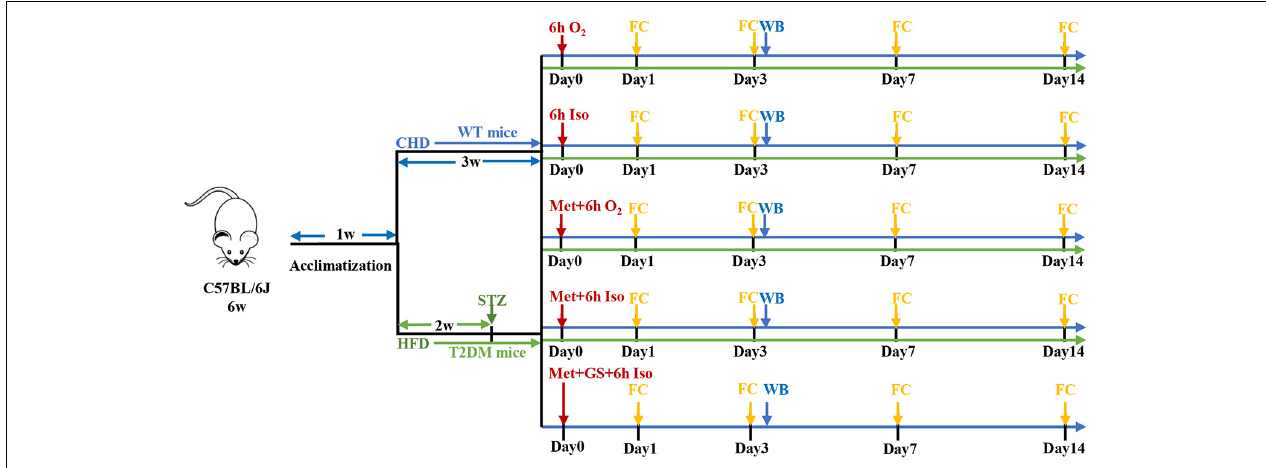
FIGURE 1 | Schematic presentation of experimental design. CHD, chow diet; HFD, high-fat diet; STZ, streptozotocin; Iso, isoflurane; Met, metformin; GS, 25% glucose solution; FC, fear conditioning test; WB, Western